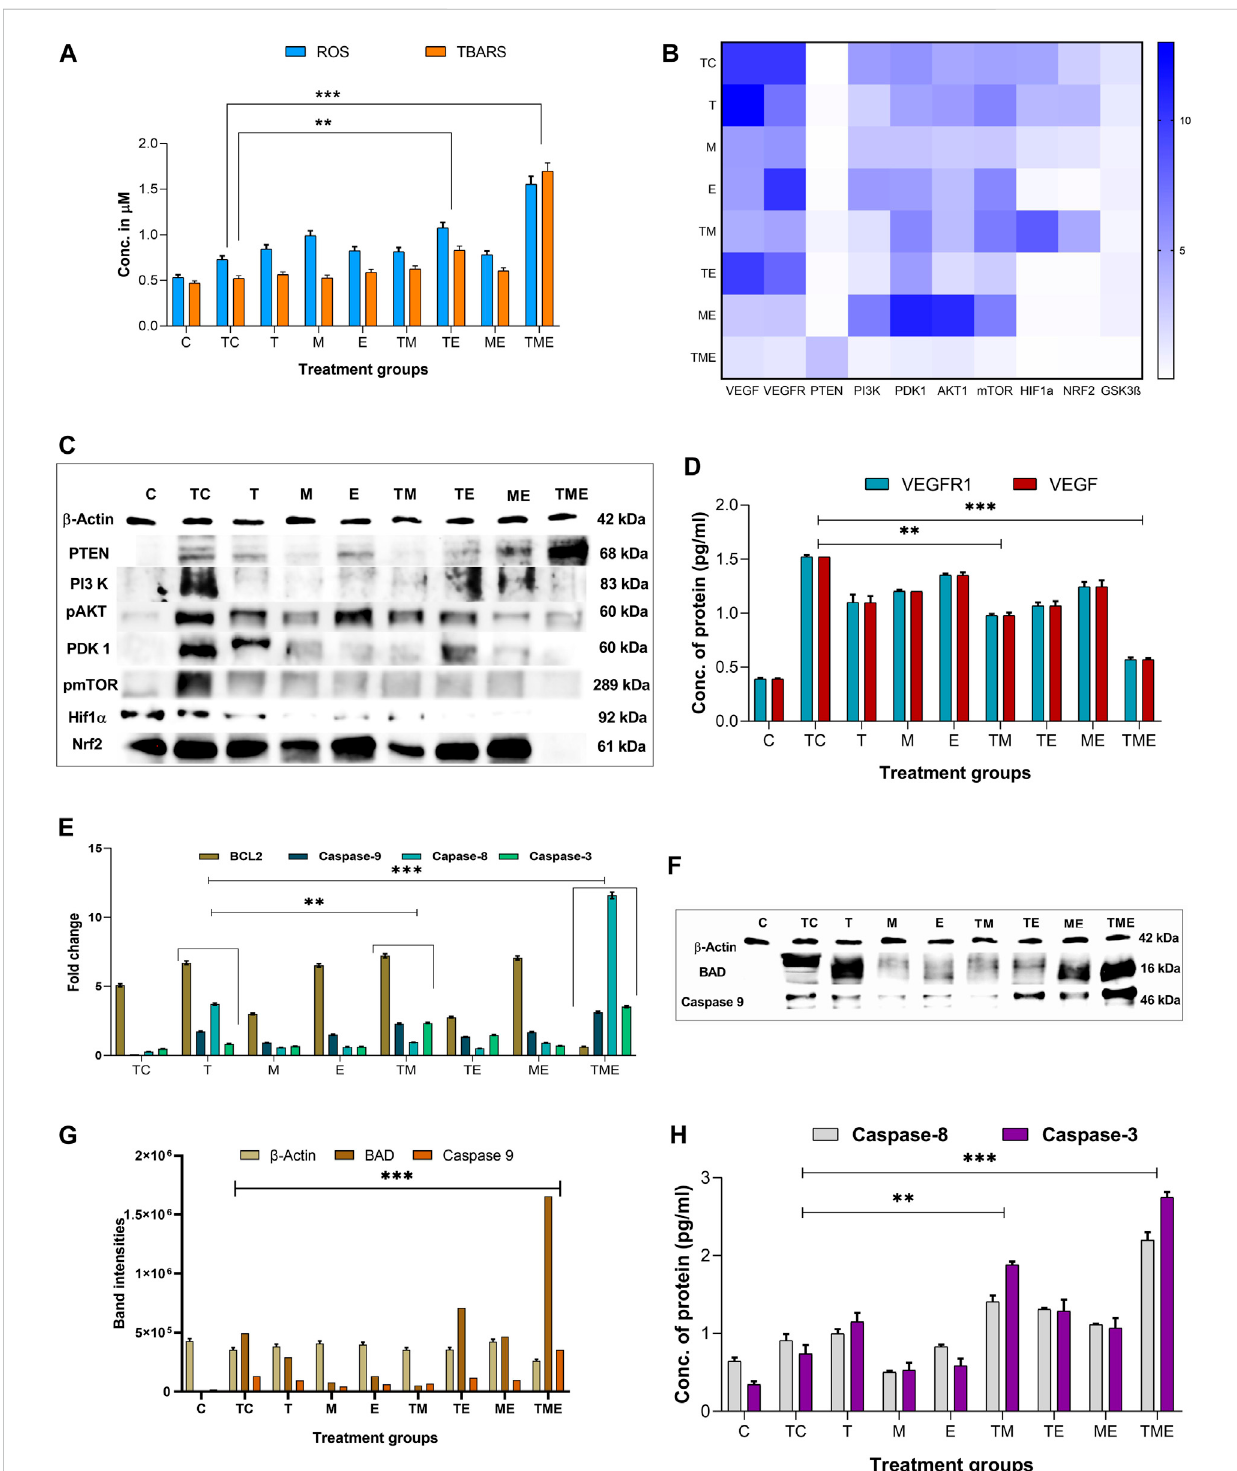
FIGURE 3 (A) shows the cumulative ROS and TBARS activity observed in different treatment groups, in which the triple-drug treatment and the dual-drug treatment of TEsigni fi cantly elevatedboth ROS and TBARS activity. (B) Heatmapfor thegeneexpression levels of VEGF, VEGFR, PTEN, PI3K, PDK1,AKT1, mTOR, GSK3 β PTEN, HIF-1 α and Nrf2; wherein dark blue indicates a fold change of 10 and white indicates a fold change of 0. The signi fi cance was calculatedusingtwo-way ANOVA. (C) Western blotbandsforproteins ofPI3K/AKT/GSK3 β /Nrf2pathway (HIF-1 α ,Nrf2PTEN, PI3K,pAKT1,PDK1and pmTOR) analysed for various treatment groups. (D) Protein levels of VEGFR1 and VEGF by ELISA. (E) Gene expression levels of apoptotic markers (BCL2andcaspase-9,8and3). (F) Westernblotbandsfortheapoptotic proteins(BADandcaspase-9)proteinsanalysed forvarioustreatmentgroups. (G) The intensitiesof apoptotic proteins BAD and caspase-9 band were calculated against β -Actin. (H) Protein levels of caspase-8 and 3 were analysed using ELISA.All the experiments were performed in triplicates, the data are represented as mean± standard deviation and thesigni fi cance was calculated using two-way ANOVA (**P < 0.001, *** P <